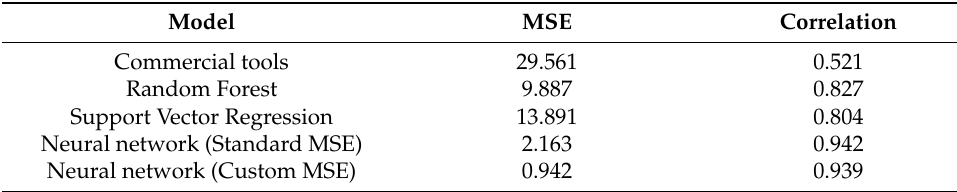
Table 4. Five-fold cross-validation results.